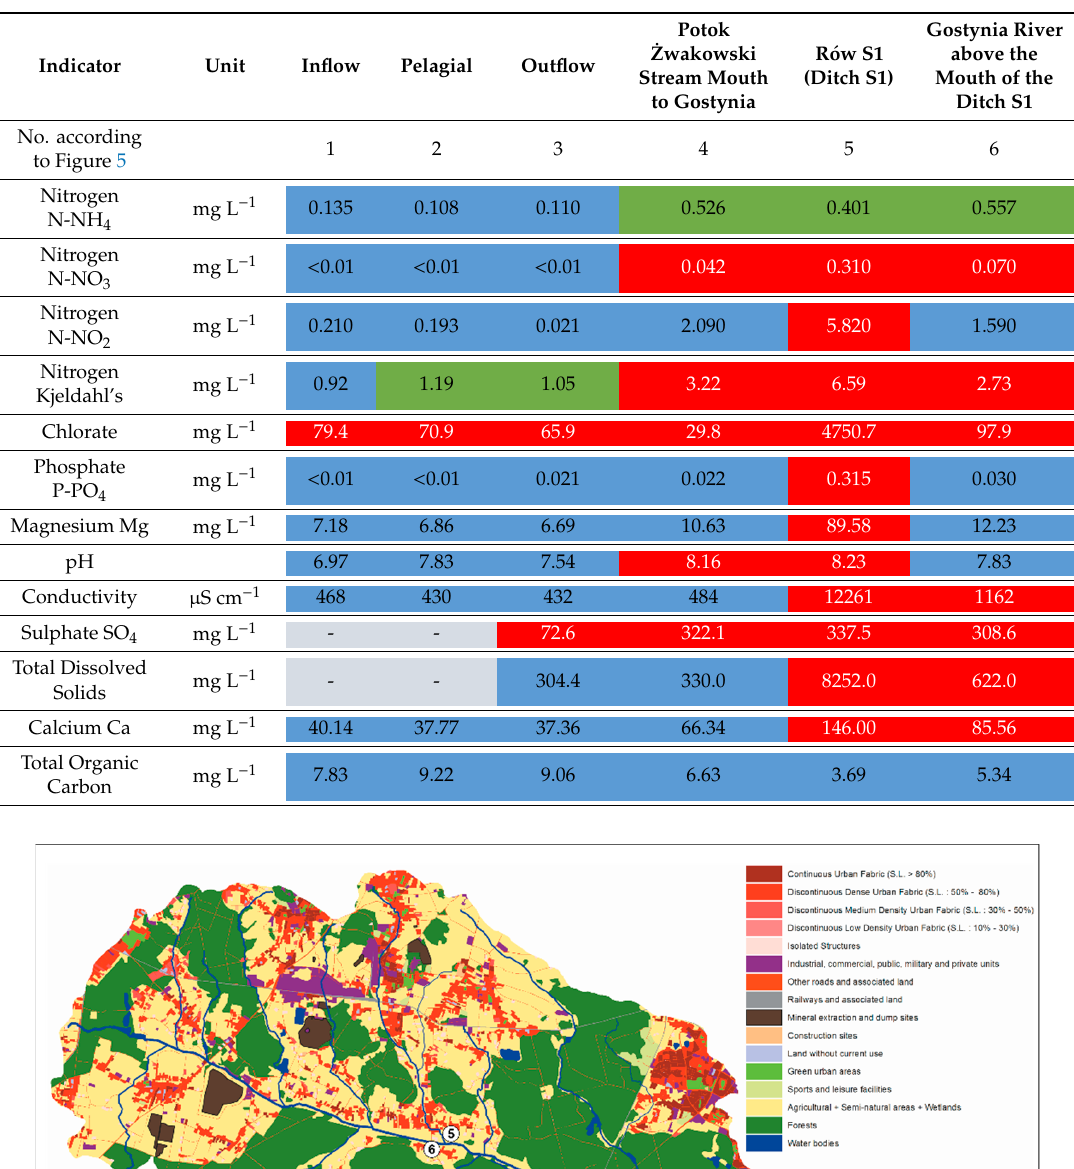
Table 7. Classification of water quality in the Paprocany reservoir and the catchment of the Gostynia River, markings of water purity class: blue—class I; green—class II; red—out-of-class water (analyses based on the data provided by the City of Tychy, the Regional Inspectorate of Environmental Protection in Katowice and by authors’ analyses).